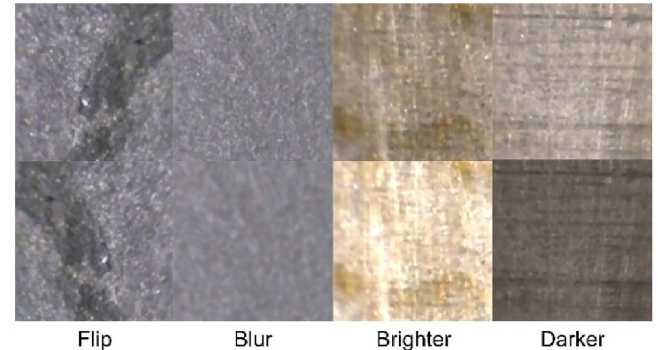
Figure 2. Data augmentation methods.